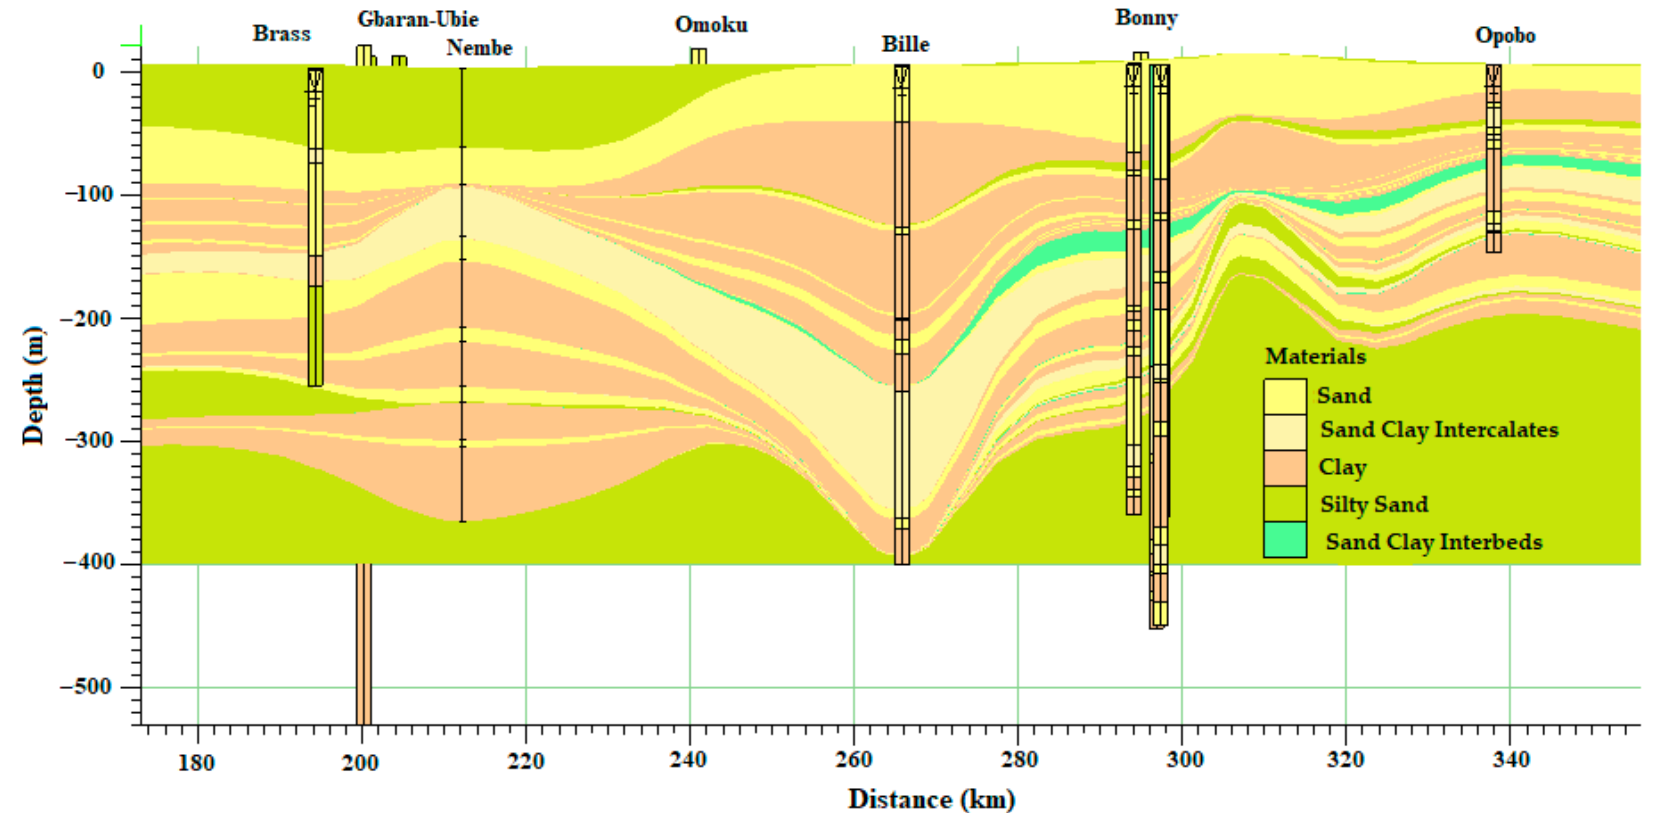
Figure 3. Hydrostratigraphic section along profile line AA I at various zones within the Niger Delta basin.